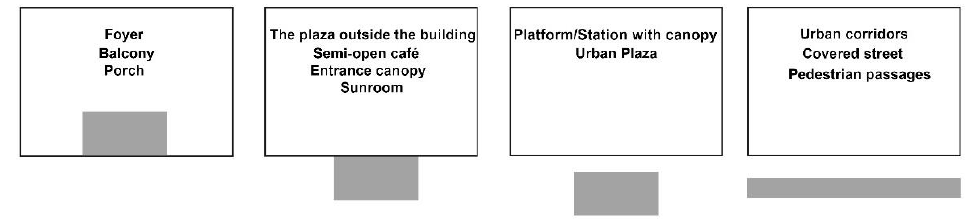
Figure 2. Some spaces that have been defined as transitional spaces in previous research.